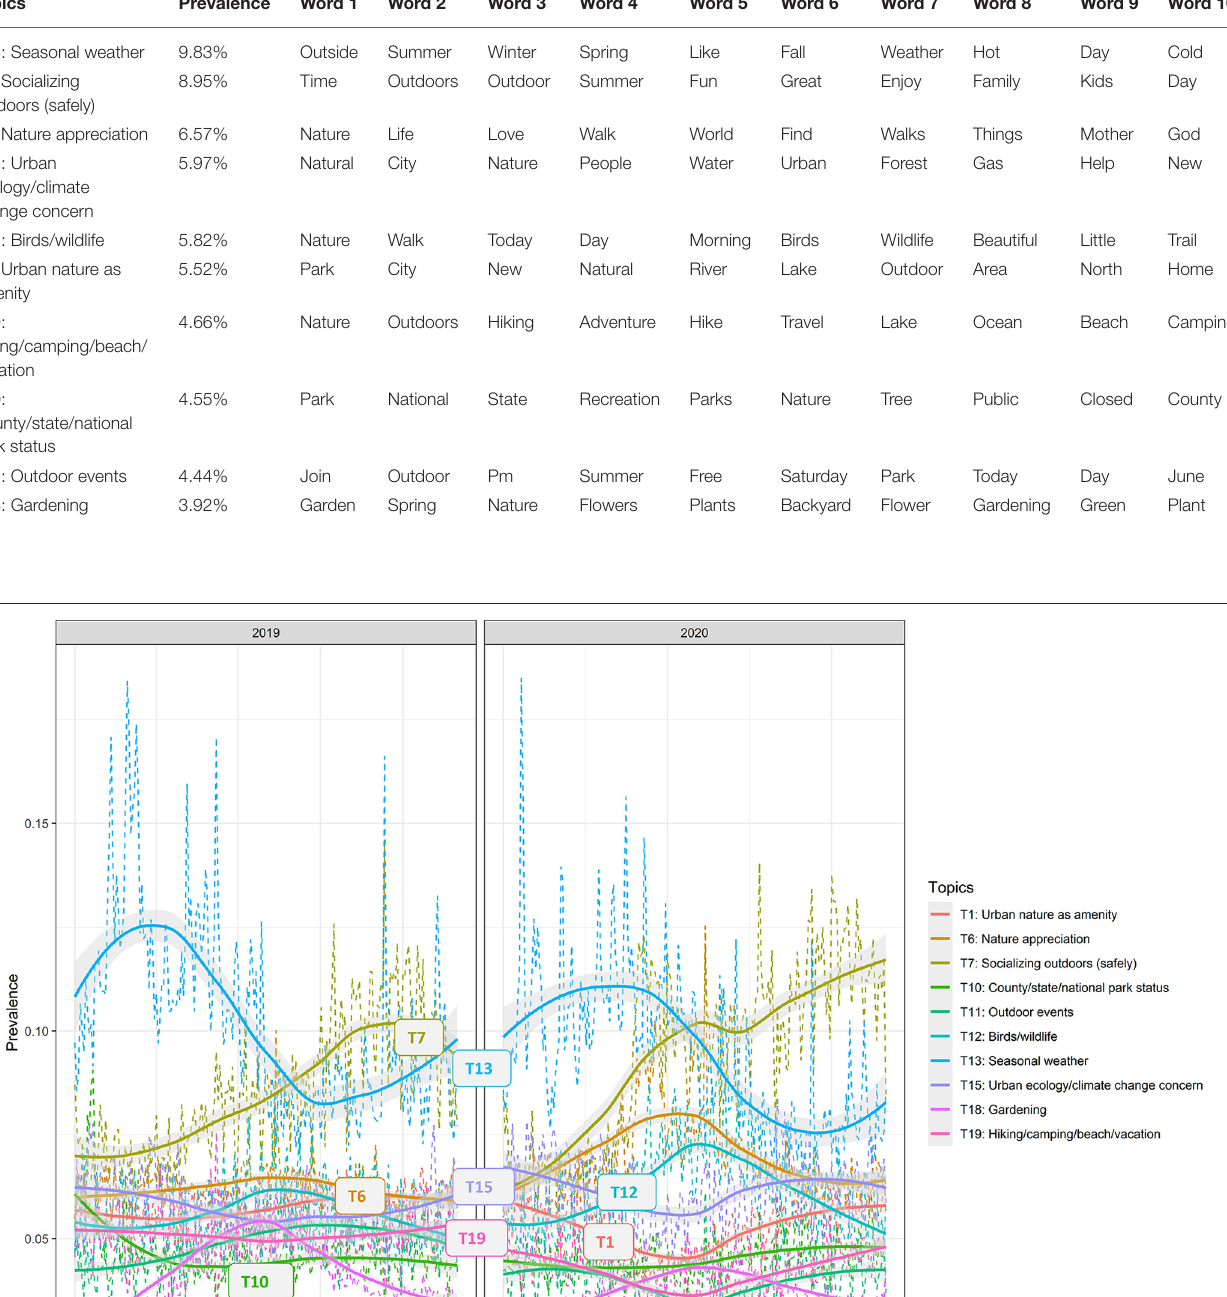
Frontiers in Sustainable Cities |